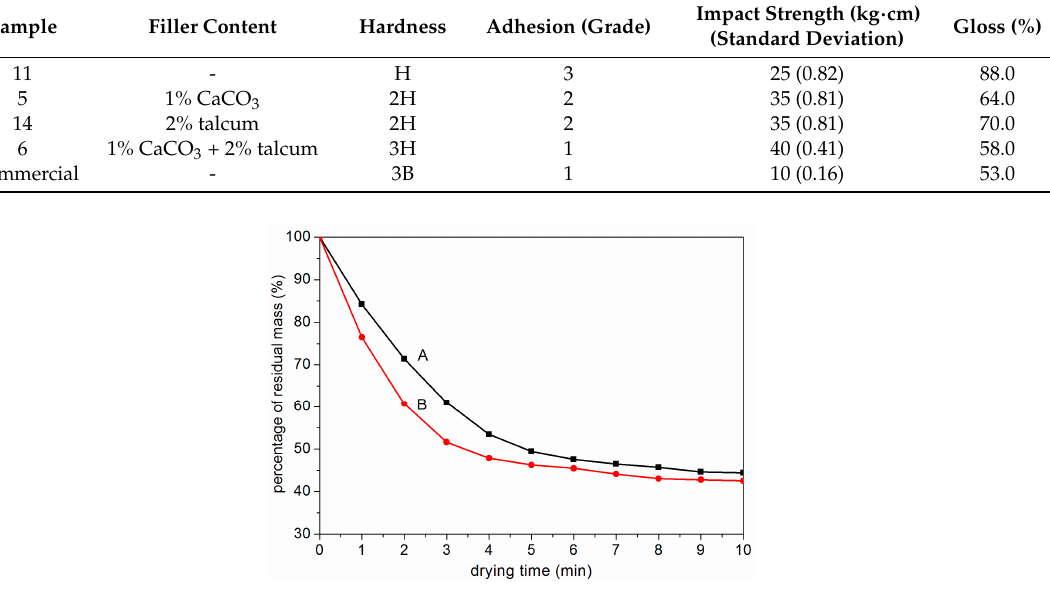
Figure 6. Weight change of WUVCW with the drying time at 40°C: 0 ( A , sample 5) and 2.0% ( B , sample 6) talcum content.